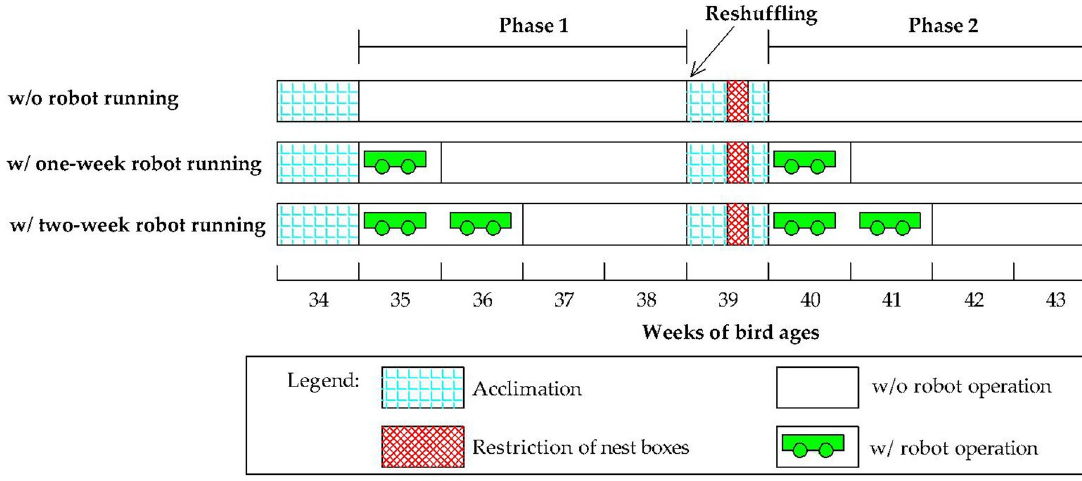
Fig 2. Schematic drawing of experimental design. “w/o” and “w/” are without and with, respectively.